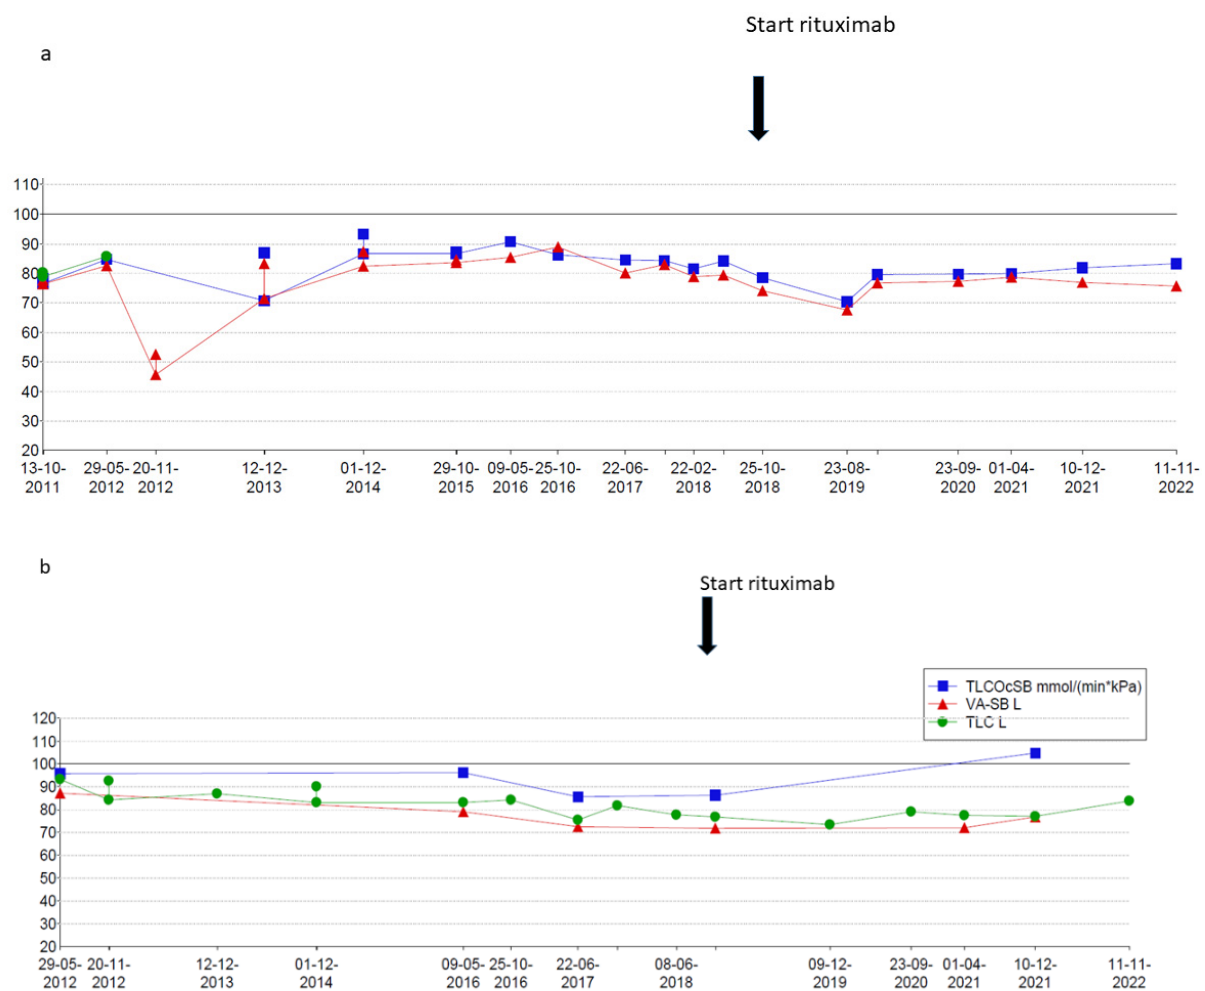
Figure 5. ( a ) Lung function over time (forced expiratory volume in 1 s (FEV1) in blue and forced vital capacity (FVC) in red expressed as percent predicted of normal. ( b ) Total lung capacity (TLC) in green measured by body plethysmography and total lung capacity measured by CO-dilution technique (TLCO-SB) in green and alveolar volume (VA-SB) in red. All values are expressed as percentage predicted of normal. Table 1. Patient characteristics, disease course, and treatment of 2 patients with idiopathic pulmo- nary hemorrhage. RTX, rituximab; MPNS, methylprednisolone; IVIG, intravenous immunoglobu- line.